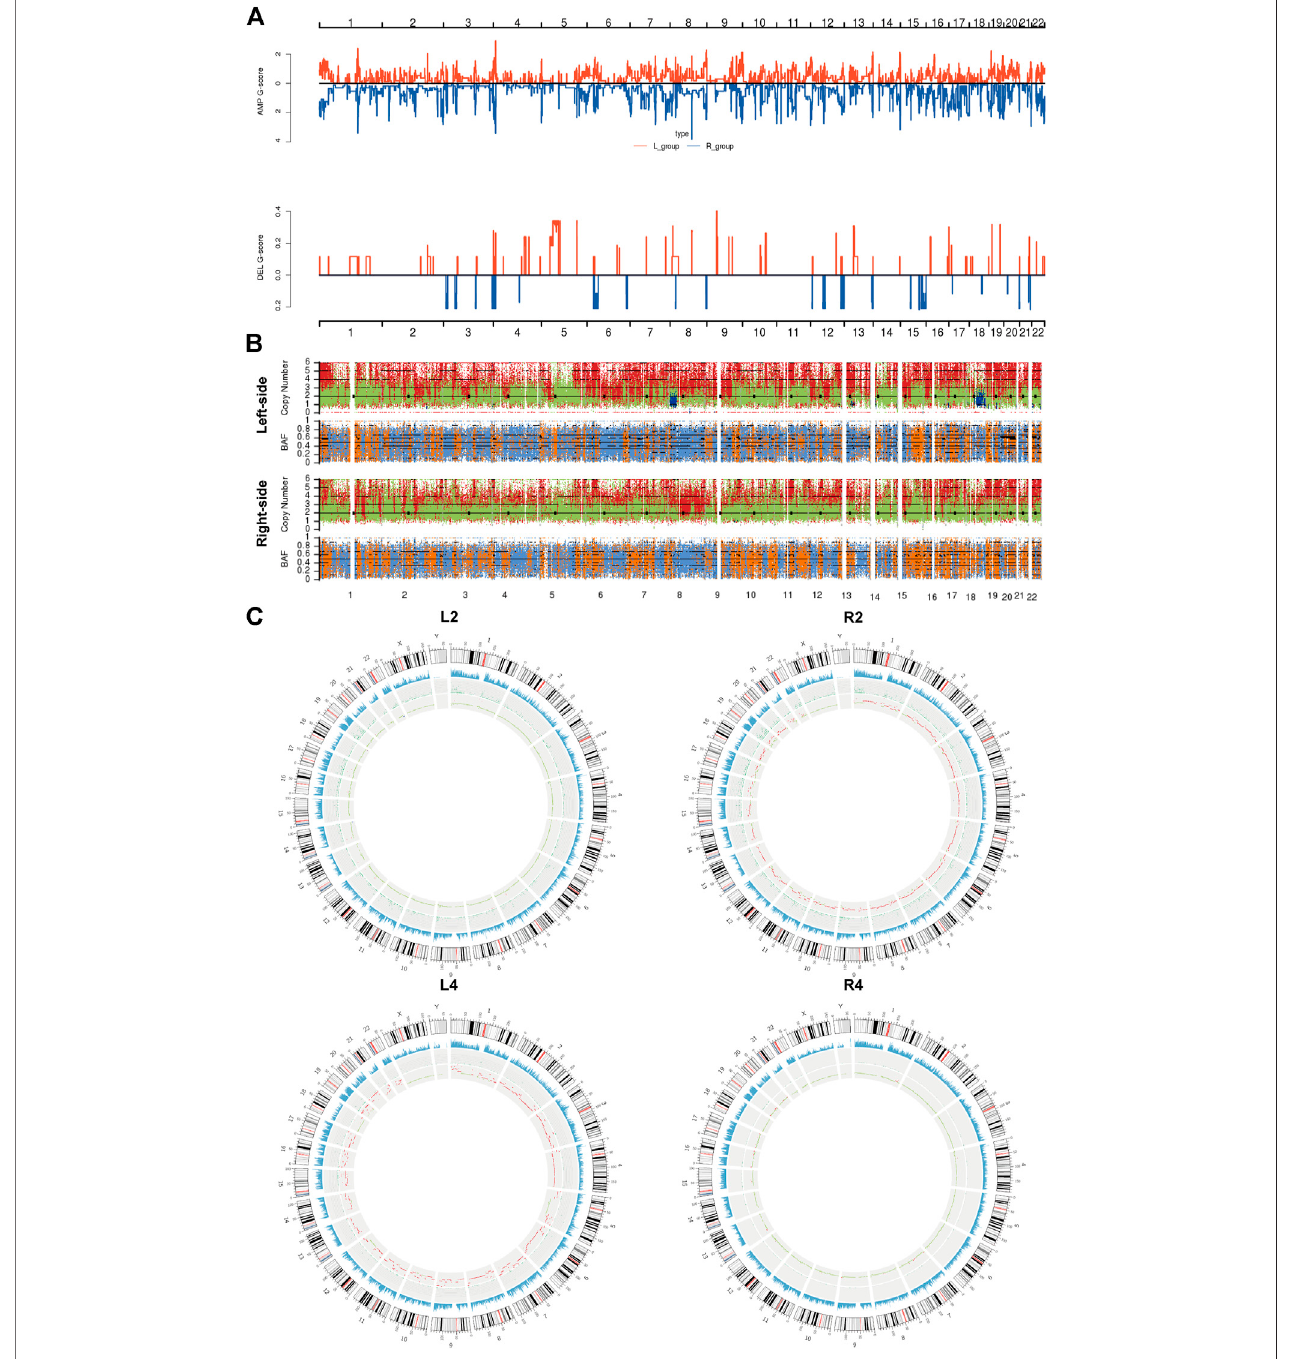
FIGURE 3 | The copy number variants analysis of sRL-CC. (A) GISTIC analysis of left-sided and right-sided lesions. The G-score represents the degree of CNV ampli fi cation (upper panel) and deletion (lower panel) . L-group means left-sided lesions and R-group means right-sided lesions. (B) The upper chart illustrates the distributionofcopynumbervariants.RedpresentstheCNVgain,greenpresentsnormalCNV,andbluepresentsCNVloss.Thelowerchartillustratesthedistributionof β allelic frequency (BAF). Orange means the normal distribution of allele and blue means loss of heterozygosity. (C) Circos plots illustrate the molecular landscape of genomeinpatients2and 4interms ofcopy numbervariants ineach patient.The fi rstcirclemeans thedepthofsequencing, the secondcircle meansthe density ofSNP insert and deletion, and the third circle means the distribution of CNVs. In the third circle, red means the CNV gains, green means normal copy number, and blue means CNV loss.